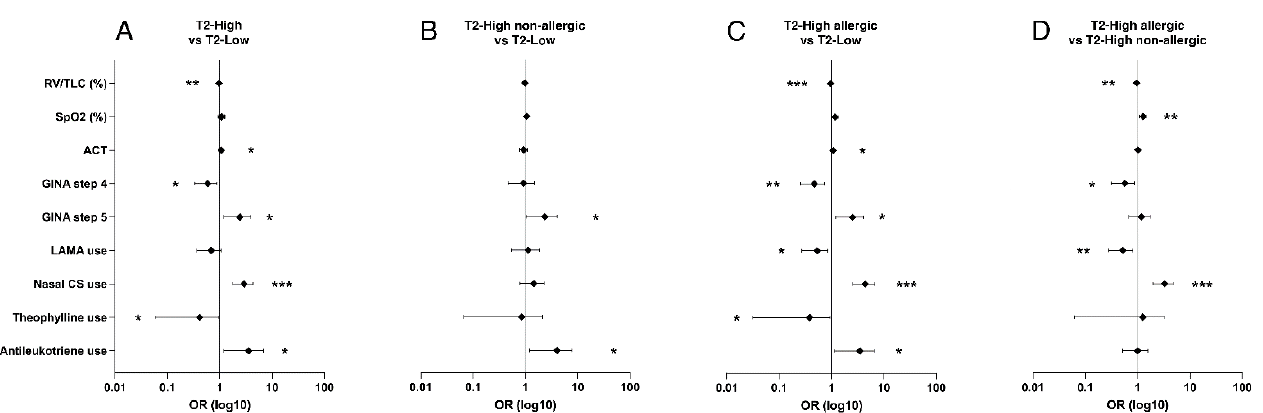
Figure 3. Forest plots of Odds Ratios ± 95% CI concerning lung function parameters and therapeutic strategies with significant differences between phenotypes at univariate analysis. Type 2 low is considered the reference in panels ( A – C ); Type 2 high non-allergic is considered the reference in panel ( D ). * = p < 0.05; ** = p < 0.01; *** = p < 0.001. The presence of comorbidities was reported in Table 5. Table 5. Prevalence of comorbidities in patients ( n = 503) stratified according to asthma phenotypes. The results are expressed as the number of subjects with percentage.